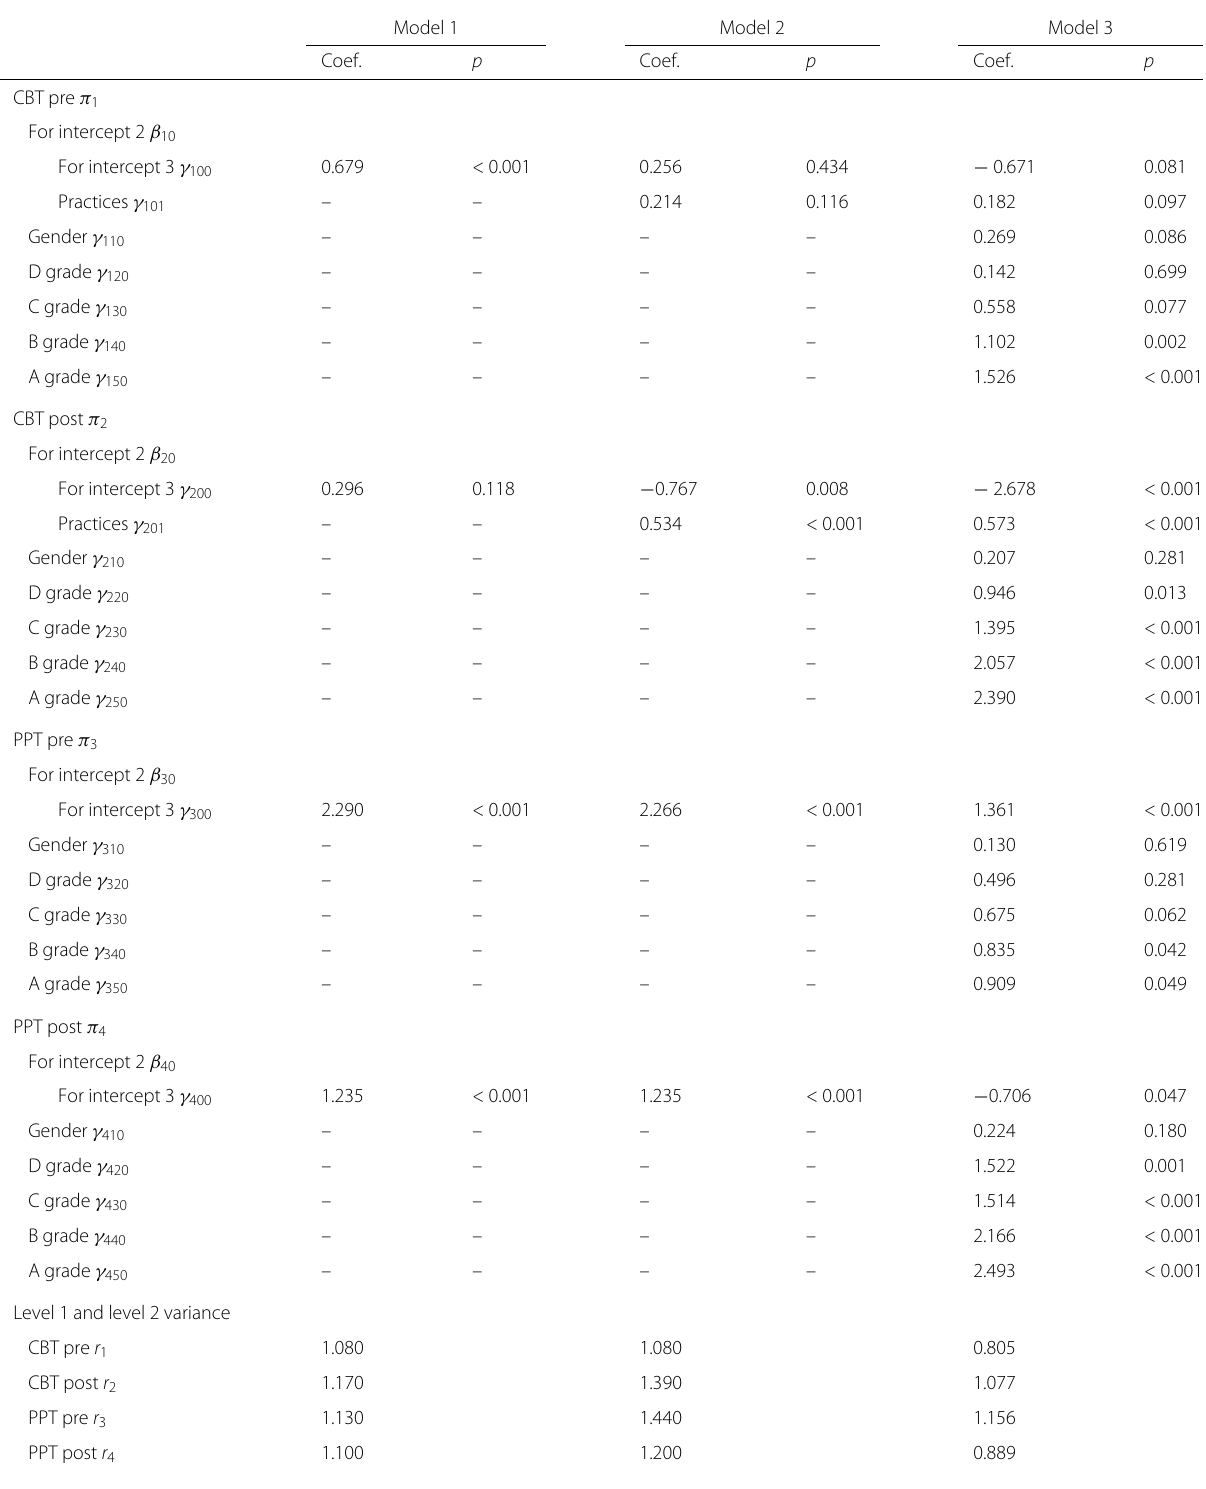
Table 5 HGLMs comparing student participation on the CBT and PPT pretest and posttests Final estimation of fixed effects with robust standard